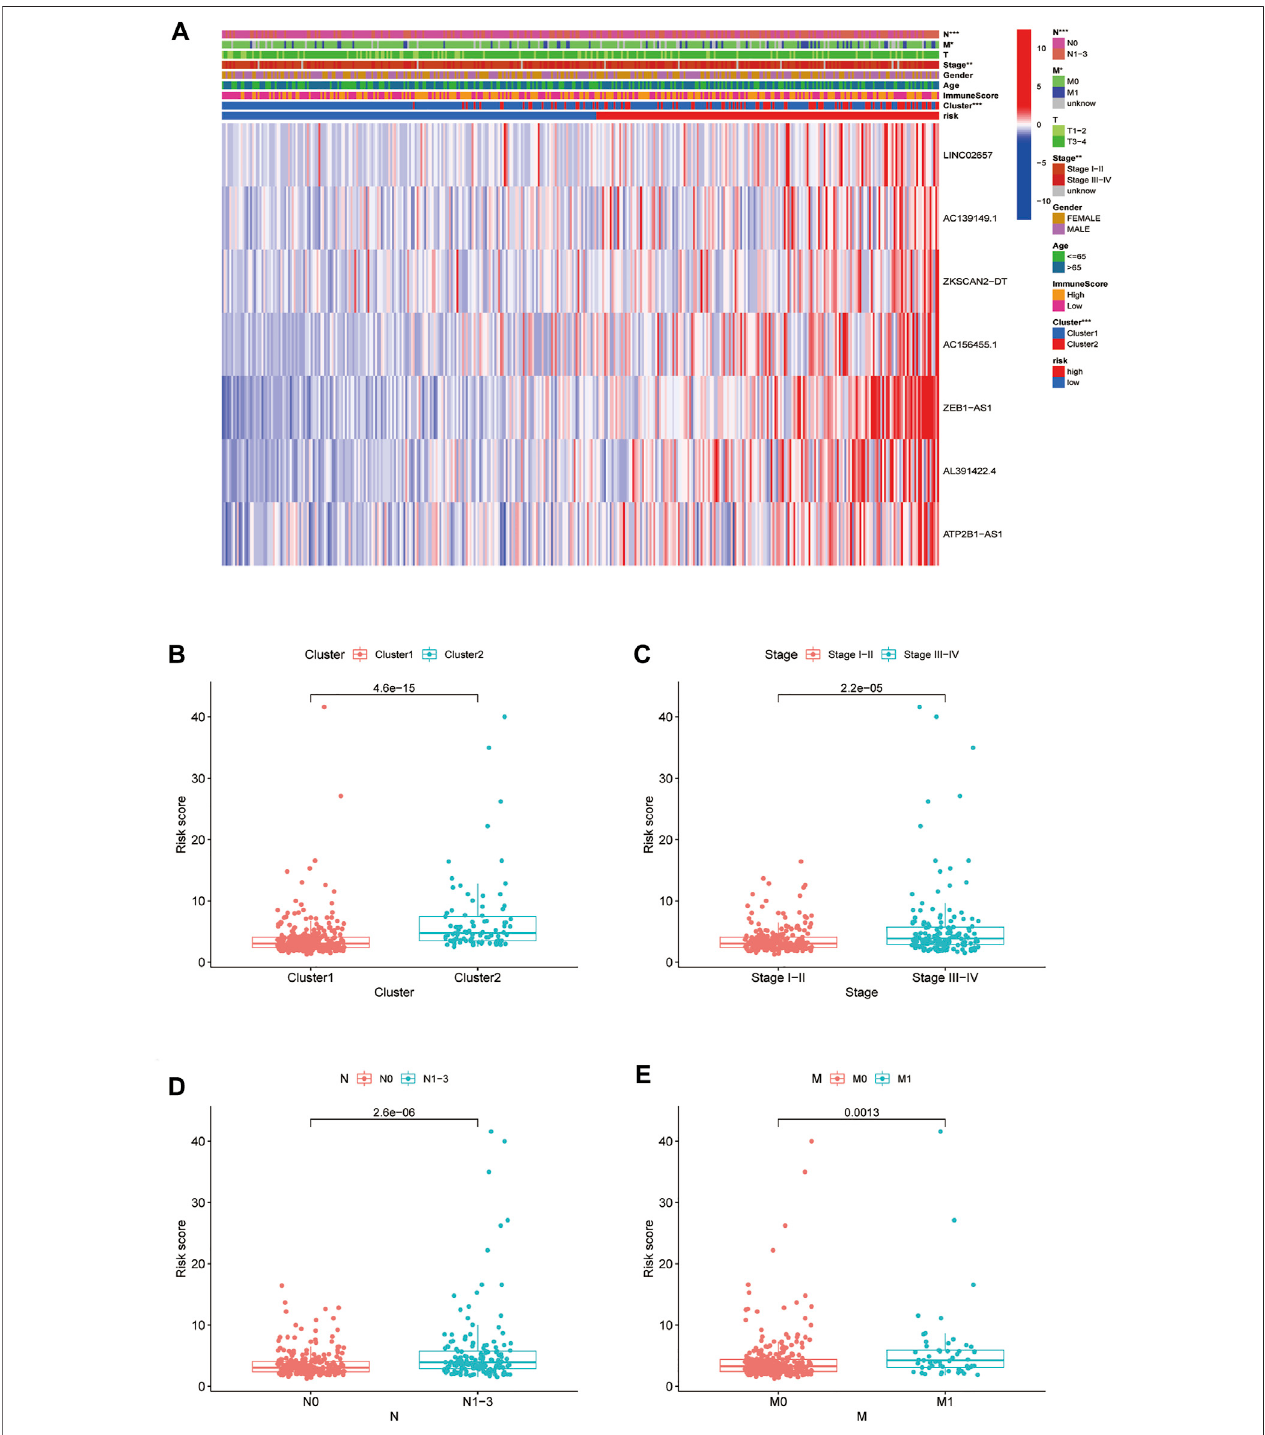
FIGURE 9 | Relationship between high-low risk groups and clinicopathological features. (A) Heatmap of correlation analysis between riskscore and clinical traits; (B – E) boxplot of relationship analysis of riskscore and clinical features (clusters, clinical traits such as stage,and N and M staging were closely related to riskscore, p <